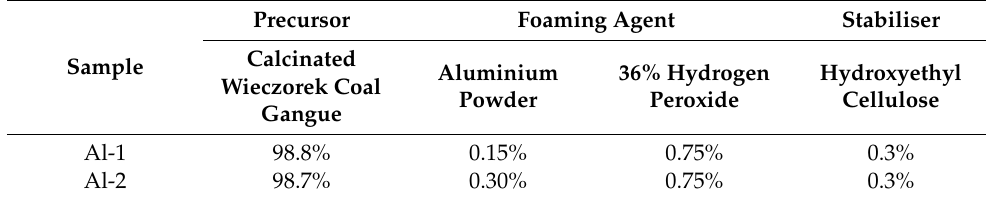
Table 3. Composition of foamed geopolymer